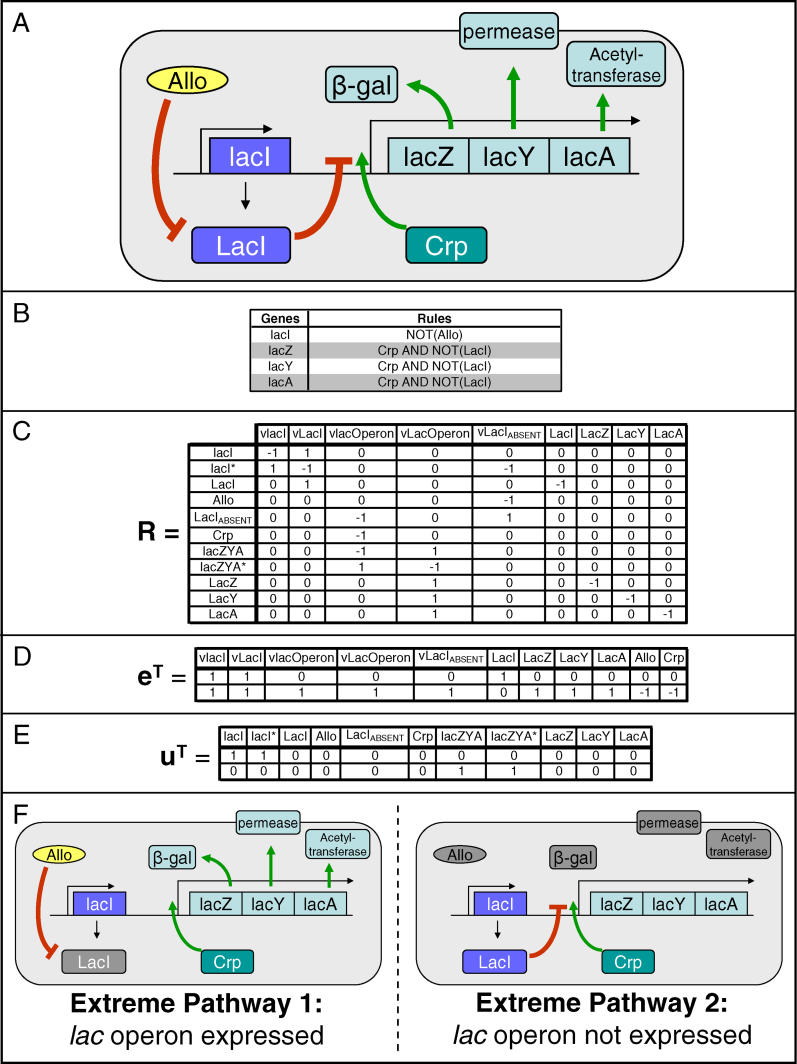
The TRS for the lac Operon in E. coli
(A) The system is defined to include the lac operon genes (lacZ, lacY, lacA), the inhibitor gene lacI, the activator Crp, and the inducer allolactose (Allo).(B) Summarizes the Boolean rules that capture the regulatory logic of the system.(C) The R matrix is shown, with each row corresponding to system components and each column specifying regulatory reactions in a quasi-stoichiometric formalism. Accordingly, a “−1” represents a consumed component, whereas a “+1” represents a produced component.(D and E) Depict the null space and left null space, respectively.(F) The two extreme pathways from the null space in (D) are presented. Pathway 1 illustrates the conditions for the activation of the lac operon (i.e., inhibition of LacI by allolactose, thus allowing for Crp-activated expression of lacZYA), whereas pathway 2 illustrates the conditions for the LacI-mediated inhibition of the lac operon.